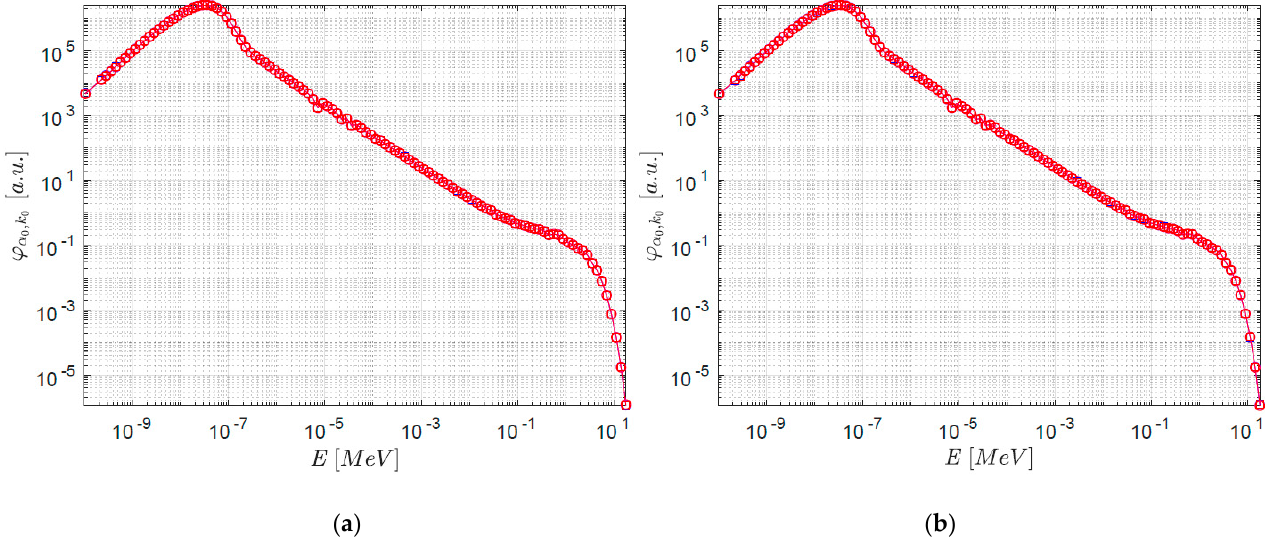
Figure 10. Direct fundamental eigenmodes of the CROCUS reactor as a function of the energy, H1 ( a ) and H2 ( b ) configurations according to the α - (blue) and k - (red) eigenvalue formulations, with (squares) and without (circles) precursor contributions.